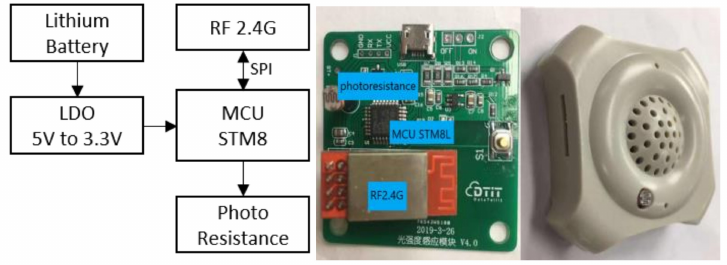
Figure 8. ALS block diagram, working board, and physical encapsulation.